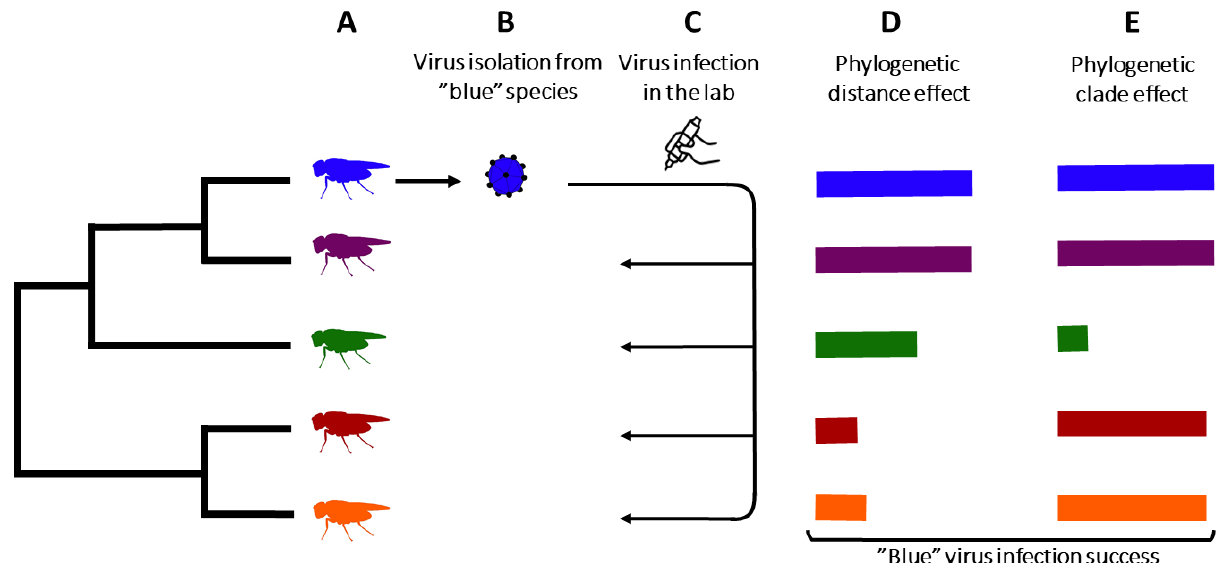
Figure 1 – Cross-infection experiment and possible ways in which host phylogeny affects virus’ shift. (A) Hypothetical host phylogeny. The flies’ shading in various colors at the tips of the tree indicate different host species. (B) Isolation of a natural virus occurring in one of the host species (blue). (C) Artificial infection of the virus isolated in other host species (purple, green, red, and yellow). (D/E) Bars represent the virus infection success in each host species, and colors indicate the host species corresponding to each bar. (D) The virus’ infection success decreases as the host relatedness to its natural host natural host species increases (phylogenetic distance effect). (E) The virus’ infection success is not related to the phylogenetic proximity to its natural host species, but there are susceptible and resistant clades scattered across the host phylogeny (phylogenetic clade